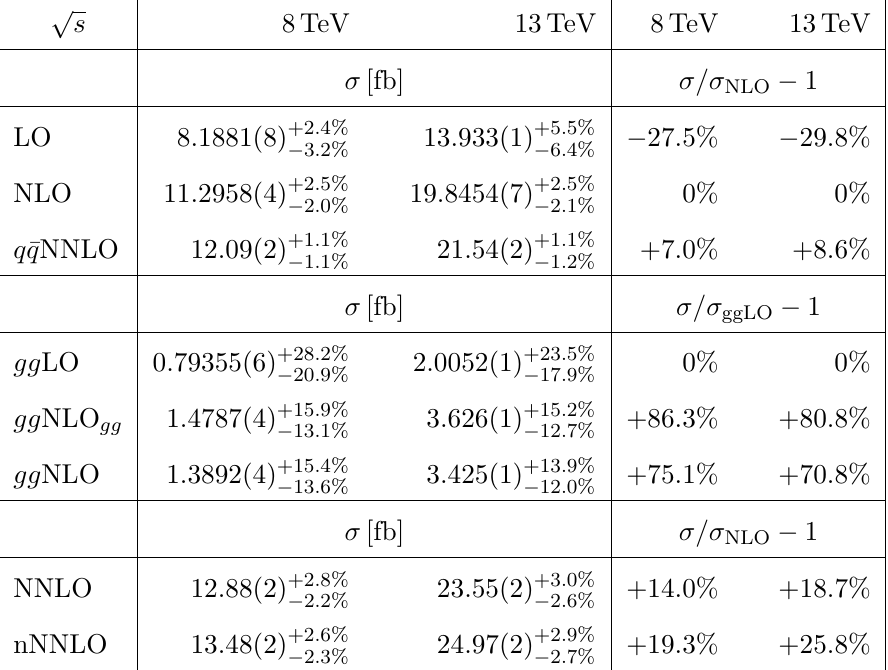
Table 3 . Fiducial cross sections at di(cid:11)erent perturbative orders and relative impact on NLO and gg LO predictions, respectively. The quoted uncertainties correspond to scale variations as described in the text, and the numerical integration errors on the previous digit are stated in parentheses; for all (n)NNLO results, the latter include the uncertainty due the r cut extrapolation [52]. p NNLO result by about 5% (6%) at s = 8 (13) TeV. Corresponding to the above-mentioned numbers, excluding the qg channels would increase the nNNLO prediction by about